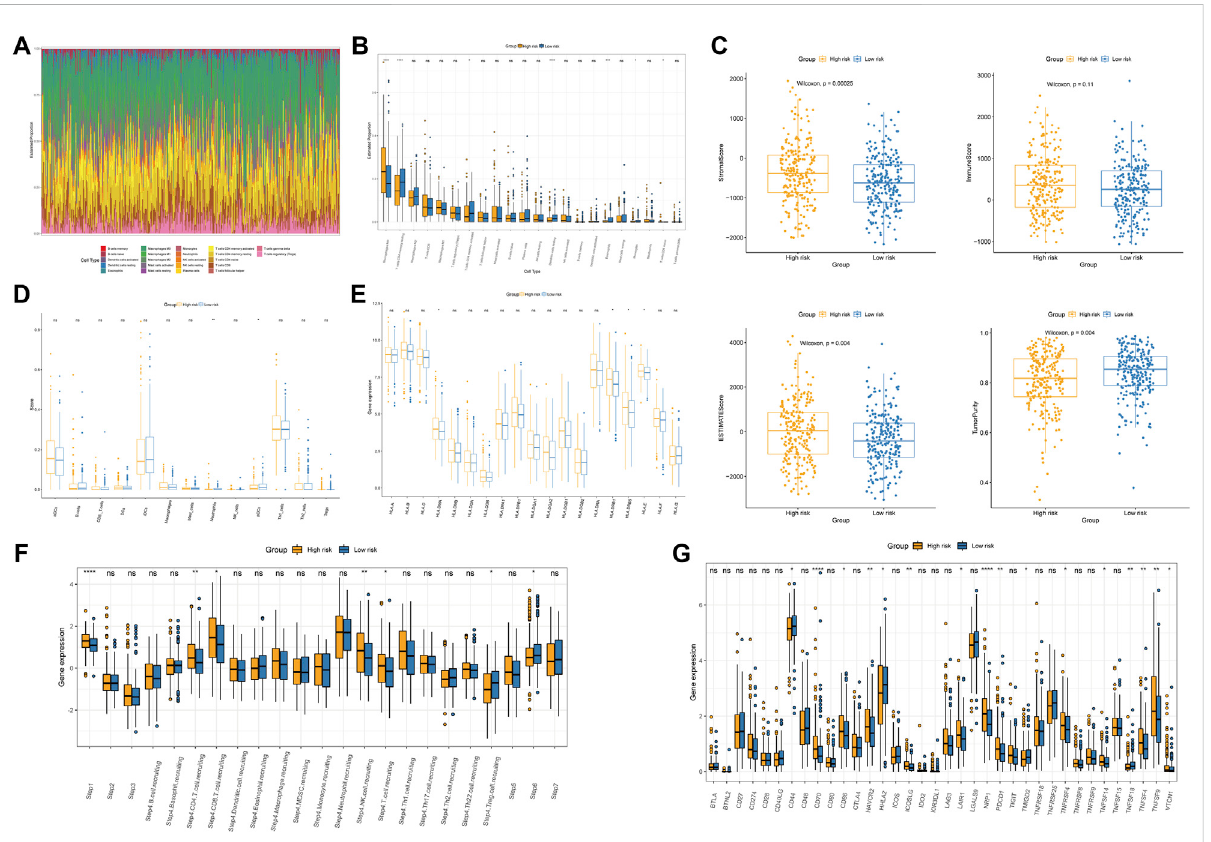
FIGURE 8 Immune pro fi les between the two subgroups. (A) Immune cell proportions in COAD patients. (B) Analysis of twenty-two types of tumor- in fi ltratingimmunecells. (C) Boxplotofthedifferencesinthestromalscore,immunescore,ESTIMATEscore,andtumorpurity. (D) Comparisonofthe levelsofin fi ltrationofimmunecellsinthetwogroups. (E) DifferencesinMHCmoleculeexpression. (F) Relativeabundanceoftheantitumorimmune response between the high- and low-risk groups. (G) Immune checkpoint expression in the high- and low-risk groups. *p < 0.05; **p < 0.01; ***p < 0.001; ****p < 0.0001; ns, not signi fi